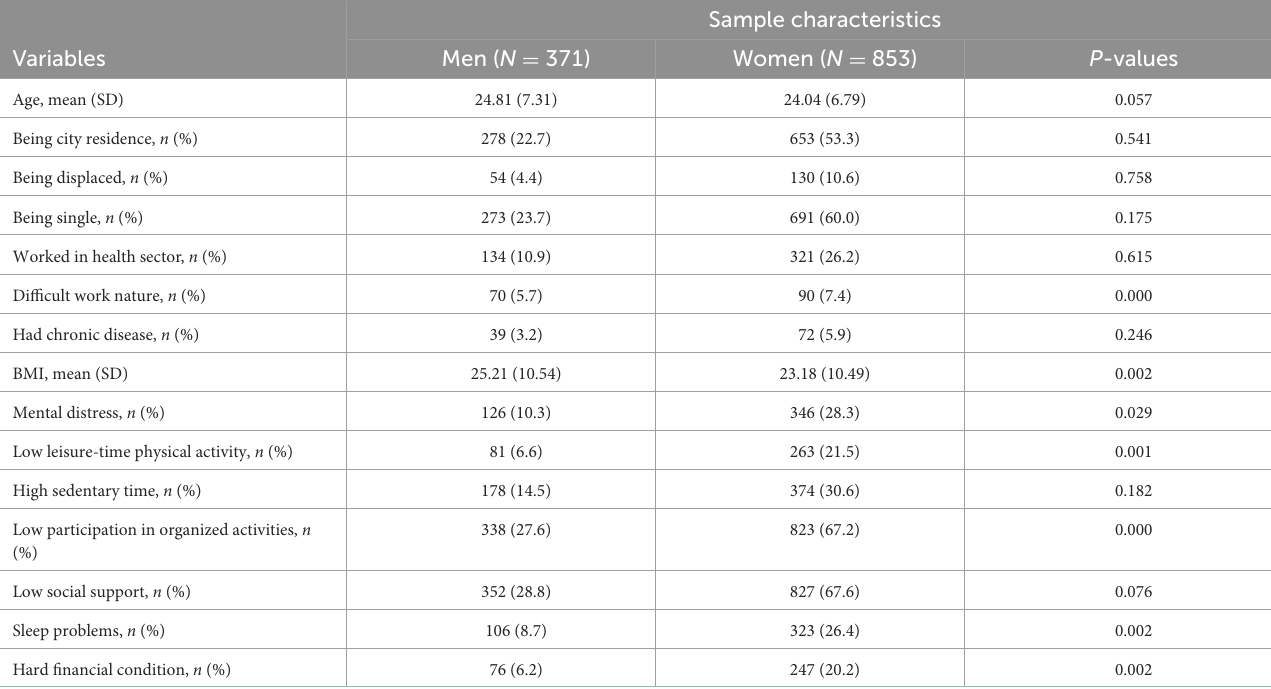
TABLE 4 Descriptive statistics of respondents ( N =